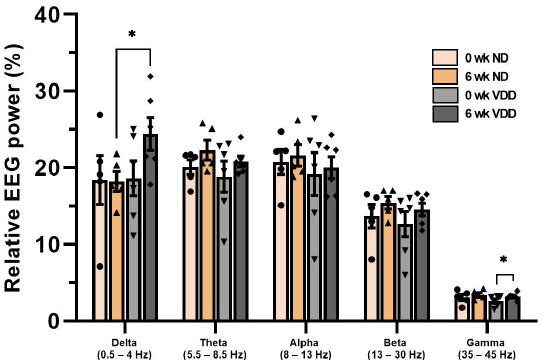
Figure 5. Spontaneous GBO increased by vitamin D deficiency. Frontal brain oscillations were analyzed by separating them into Alpha (8–13 Hz), Beta (13–30 Hz), Gamma (35–45 Hz), Delta (0.5–4 Hz), and Theta (5.5–8.5 Hz). Each frequency range’s data are normalized by total power (0.5–1000 Hz). Data are expressed as mean ± SEM, and * p < 0.05 by the Student’s t -test.